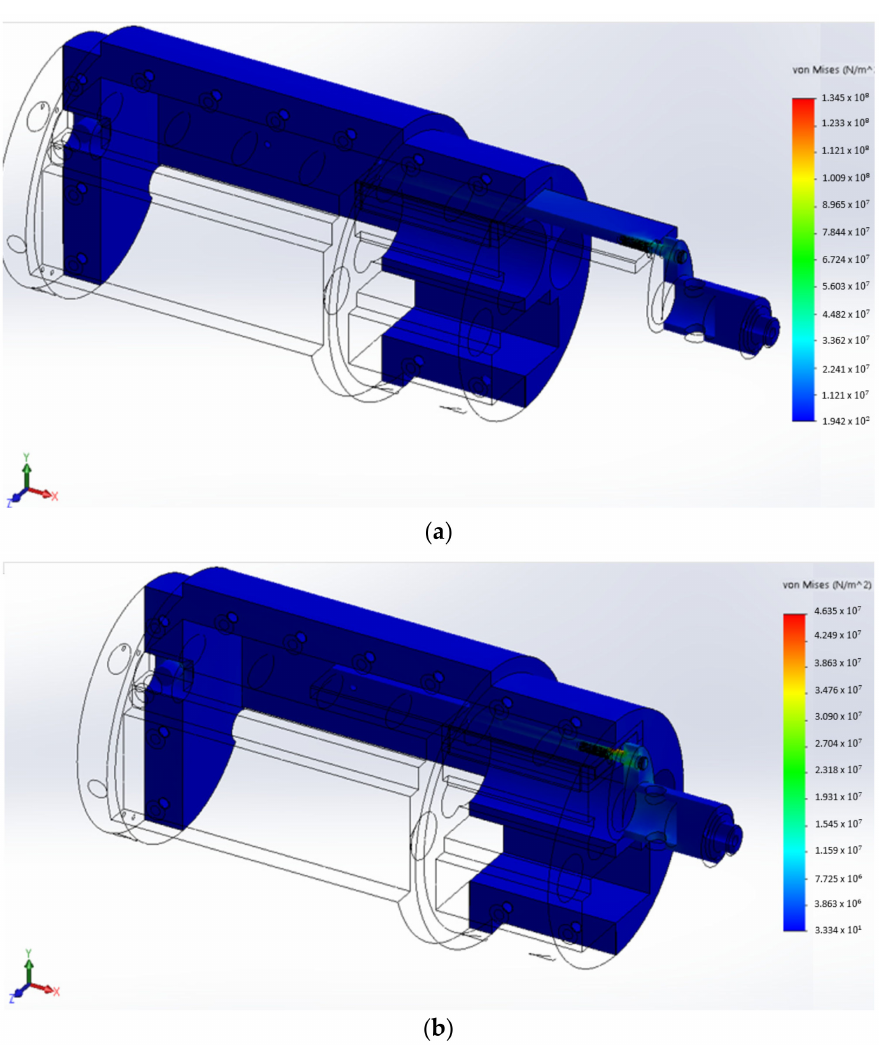
Figure 9. Stress FEM simulation when the maximum torque is exerted by the actuator rod: ( a ) extended; ( b )